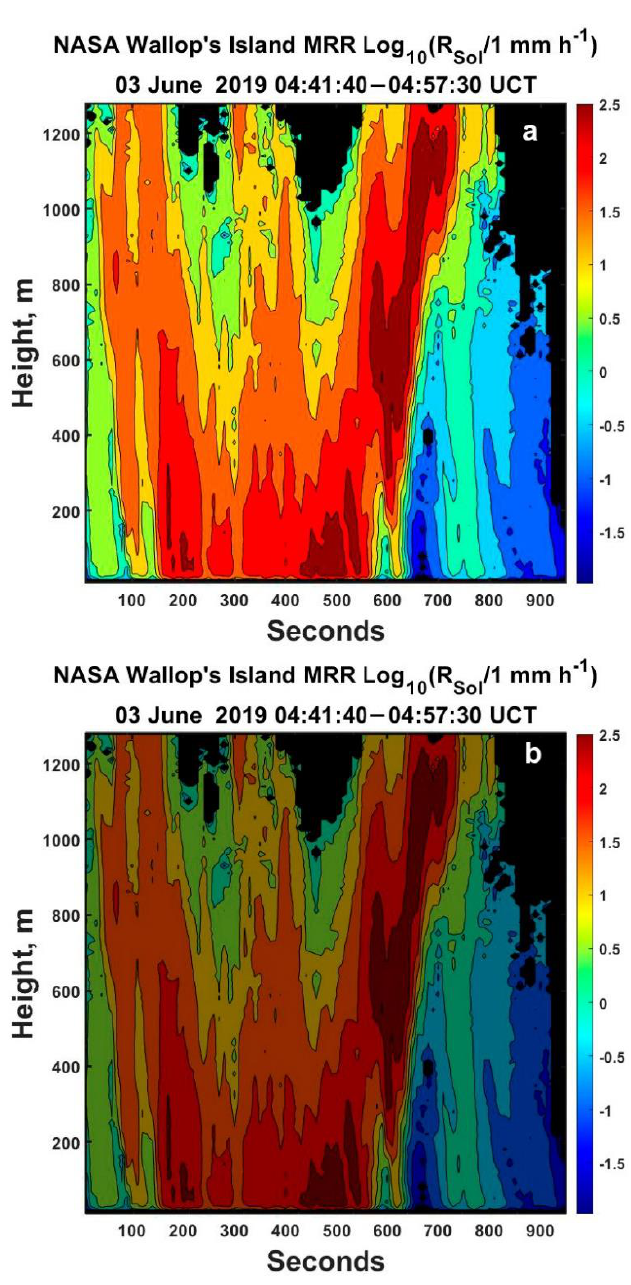
Figure 5. ( a ) Time–height plot of the base 10 logarithm of the vertical-air-velocity-corrected Doppler spectra rainfall rate using data from a NASA Wallop’s Island MRR radar (from Jameson [7]) during the passage of a line of convection and ( b ) the same plot with an overlay of the 2D IXH results. Note that this time there are no regions of statistical homogeneity, apparently because of the variability of R w in both height and time.